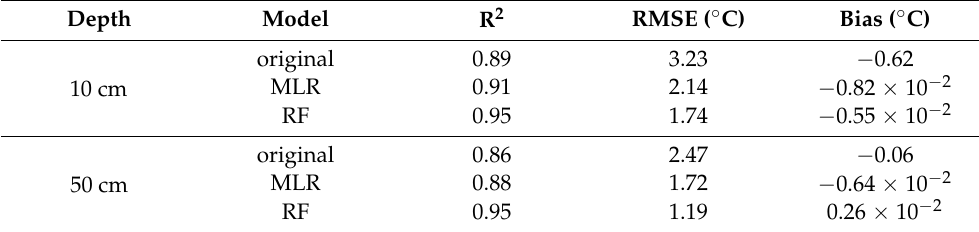
Table 3. Assessment of modified soil temperature by correct models, MLR: Multiple Linear Regression Model, RF: Random Forest